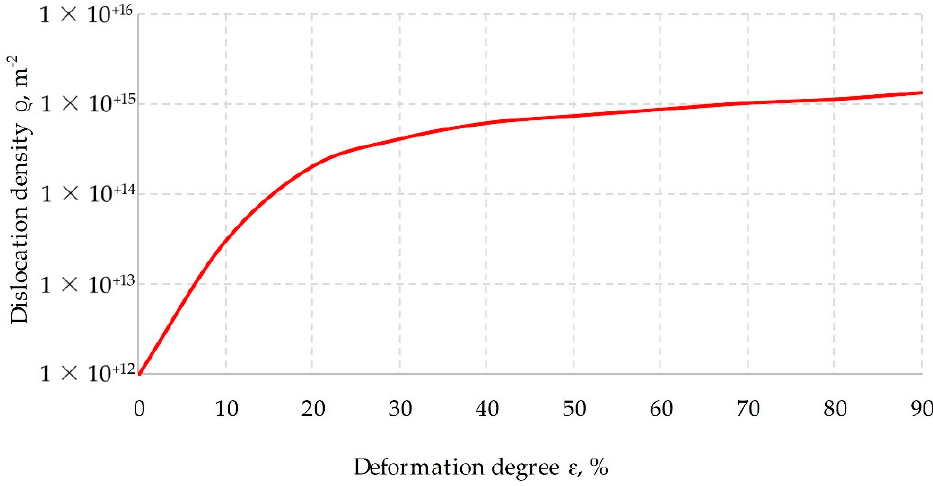
Figure 6. Change in the dislocation densities in ferritic steel depending on the deformation degree. Substituting the values of the diffusion coefficients for the elements C, N, H and O (Figure 5) and the density of